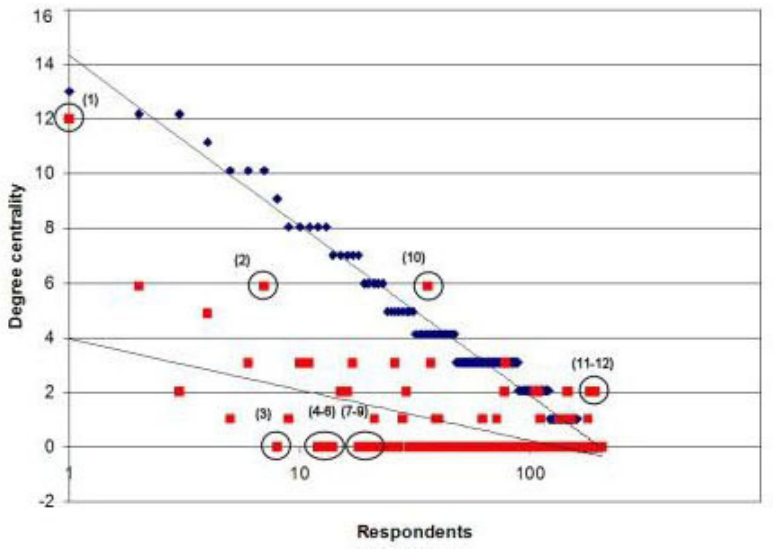
Fig. 2 . Correlation between individual in-degree centrality in the gear network and degree centrality in the knowledge